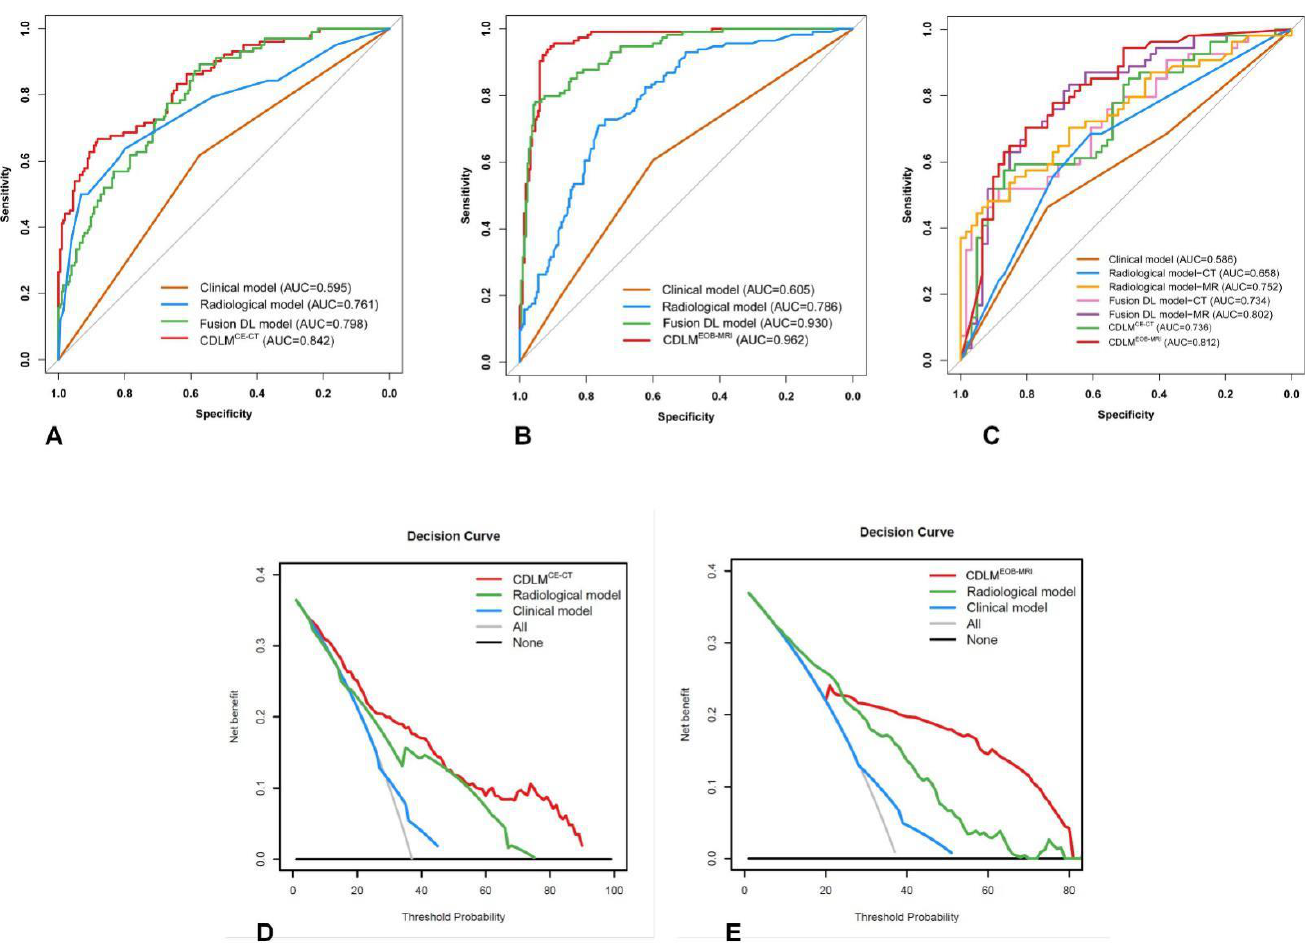
Figure 2. Predictive performance of the developed models. ( A – C ) ROC curves of the developed models in the CE-CT training cohort, EOB-MRI training cohort and prospective validation cohort 2; ( D , E ) decision curves of CDLM CE-CT and CDLM EOB-MRI .